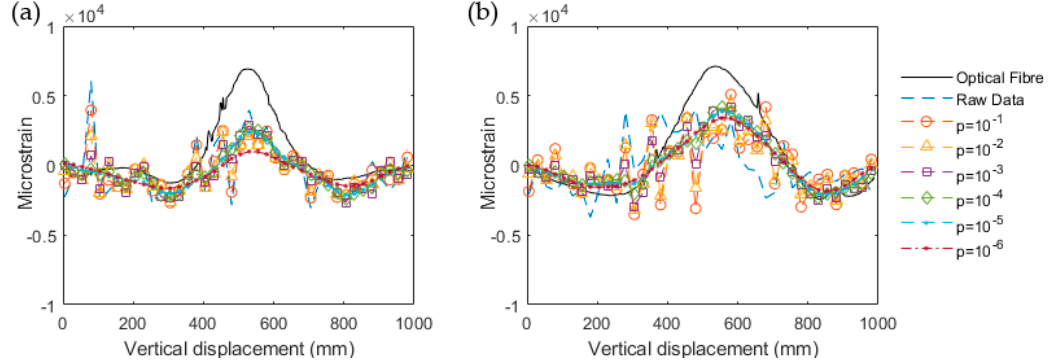
Figure 9. OOP deformation test Step 3: Strain along the vertical line ( a ) at 800 mm and ( b ) at 1000 mm for different (cid:1868) parameters, no filter, and optical fibre.